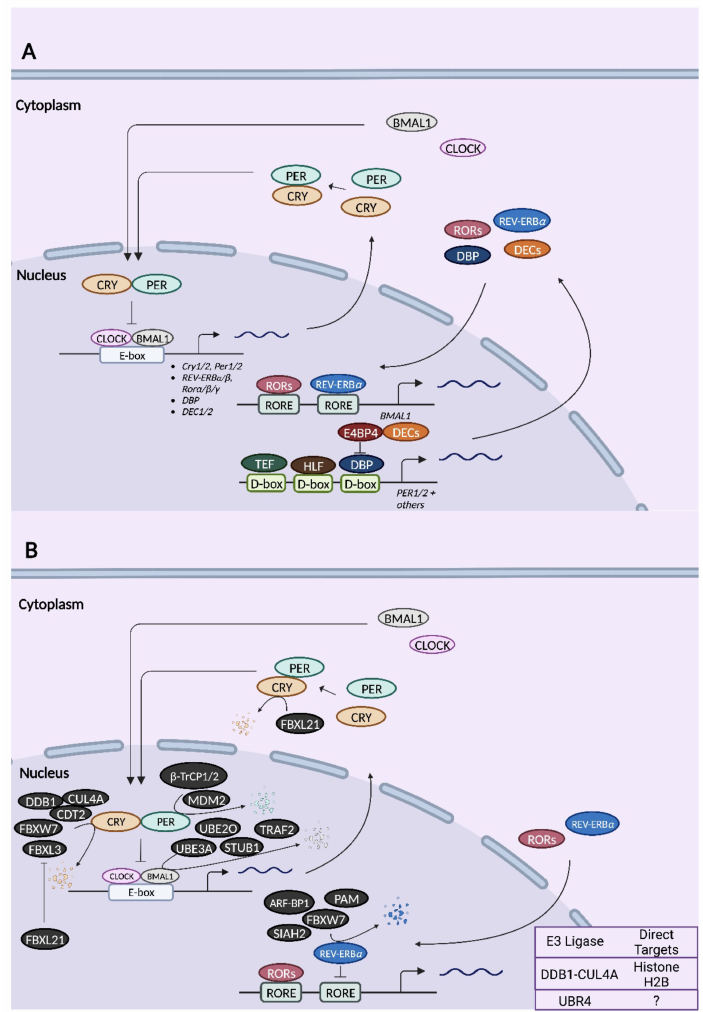
Figure 2. Schematic of mammalian circadian clock transcription–translation feedback loops (TTFLs) ( A ) and the relationships of known E3 ligases to core clock proteins ( B ). ( A ) In the primary TTFL of mammals, transcription factors CLOCK and BMAL1 heterodimerize and activate the transcription of target genes including Cry1/2, Per1/2, Rev-Erb α / β , Ror α / β / γ , Dbp, and Dec1/2 by binding to the E-box elements in their promoters. Once translated, PER and CRY proteins accumulate in the cytoplasm before heterodimerizing and translocating to the nucleus, where they ultimately repress E-box-dependent transcription. In a secondary TTFL, ROR α / β / γ binds to ROR elements (RORE) in the promoters of Bmal1 and other genes to activate their transcription. In contrast, REV-ERB α / β binds to ROREs to repress transcription. Another auxiliary feedback loop involves DBP, TEF, and HLF, which bind to the D-box elements of Per1/2 genes (among others), initiating D-box-mediated transactivation. Binding of E4BP4 at D-box elements results in transcriptional repression. ( B ) All mammalian E3 ubiquitin ligases that have been demonstrated to target a core clock protein for degradation are indicated in black. E3 ligases whose targets are either unknown or not core clock proteins are indicated in the chart in the bottom right corner. Except for FBXL3 and FBXL21, the site of action (nucleus vs. cytoplasm) for all other E3 ligases is unknown. For illustrative purposes, these E3 ligases are shown as acting in the